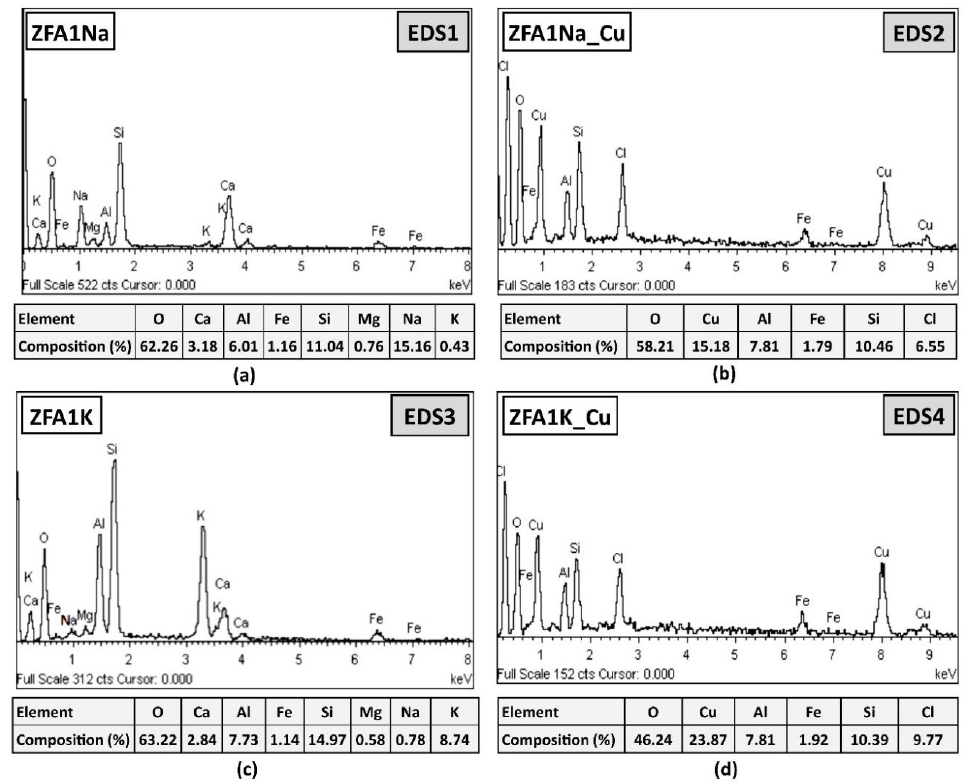
Figure 9. EDS spectra and elemental composition in terms of atomic percentage (at. %) of the synthetic zeolites prior to (( a ) ZFA1Na and ( c ) and ZFA1K) and after removal (( b ) ZFA1Na_Cu and ( d ) ZFA1K_Cu) of Cu(II) ions, respectively (shown as square regions in Figure 3). Initial Cu ion concentration, 200 mg·L −1 ; zeolite dosage, 0.5 g·L −1 .